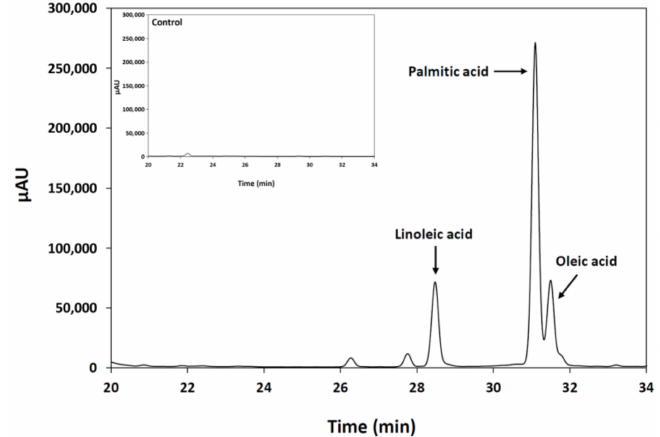
Figure 4. HPLC analysis of the fatty acids formed after the hydrolysis of 1-palmitoyl-2-oleoyl-3- linoleoyl- rac -glycerol by the lipase of M. echinosphaera CBS 575.75. The enzymatic hydrolysis conditions were pH 6.8, 25 ◦ C and 2-h incubation time. (Inset: control sample contained only 1-palmitoyl-2-oleoyl-3-linoleoyl- rac